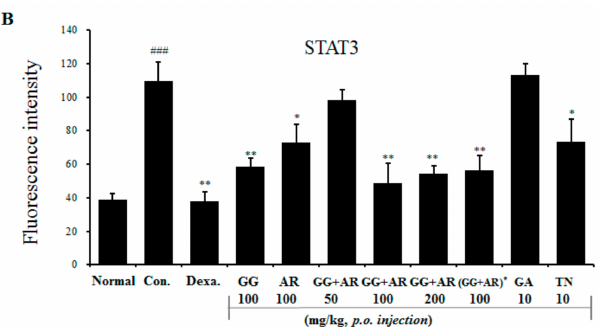
Figure 7. Inhibitory e ff ect of GG, AR, GG plus AR, GA, and TN on STAT3 transcription factor using immunofluorescence analysis in lung tissues of COPD model mice. Mice were challenged by intratracheal injection of CFD, and then treated with GG, AR, GG plus AR, GA, and TN over a period of 12 days. The expression of STAT3 transcription factor in lung tissues was determined by immunofluorescence staining ( A ). The mean of fluorescence intensity quantified from images was obtained from 3 independent experiments using Image J software ( B ). Normal: normal group; Con.: CFD, CFD-induced COPD model group; Dexa.: CFD solution and administrated with dexamethasone 3 mg / kg group; GG 100: CFD solution and administrated with GG extract 100 mg / kg group; AR 100: CFD solution and administrated with AR extract 100 mg / kg group; GG + AR 50: CFD solution and administrated with GG plus AR extract 50 mg / kg group; GG + AR 100: CFD solution and administrated with GG plus AR extract 100 mg / kg group; GG + AR 200: CFD solution and administrated with GG plus AR extract 200 mg / kg group; GG + AR 100*(trial product): CFD solution and administrated with GG plus AR (trial product) 100 mg / kg group; GA 10: CFD solution and administrated with GA 10 mg / kg group; TN 10: CFD solution and administrated with TN 10 mg / kg group. The statistical significance of di ff erences between control and treatment groups were assessed by ANOVA and Duncan’s multiple comparison test. Data represent the mean ± SEM of 8 independent experiments. (### P < 0.001, significantly di ff erent from the value of normal group. * P < 0.05 and ** P < 0.01 significantly di ff erent from the value of control